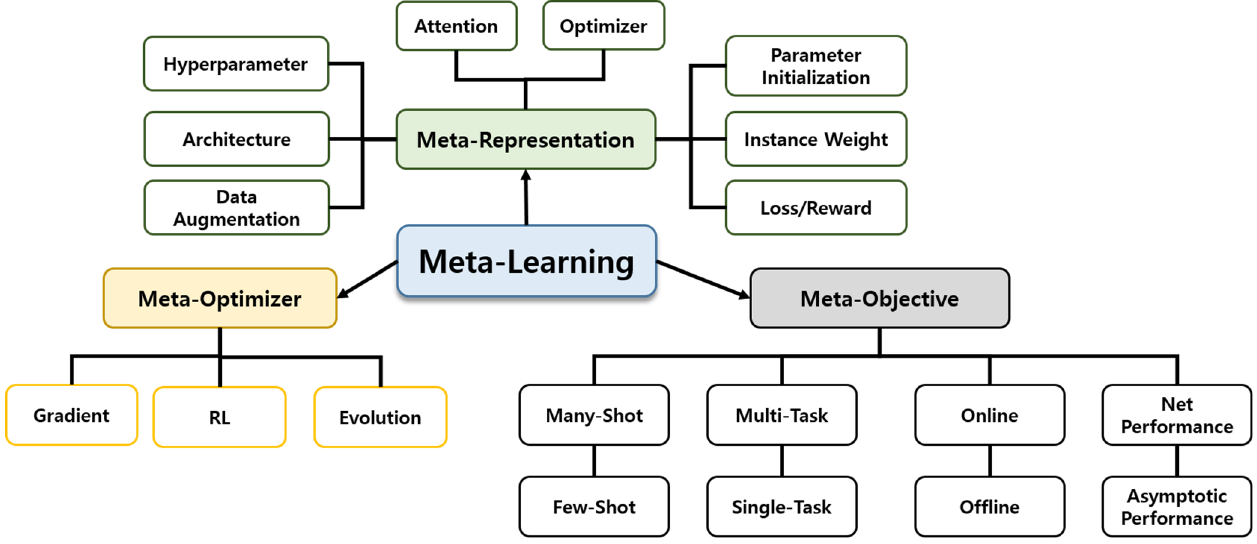
Figure 2. Meta ‐ learning technology trend diagram. Figure 2. Meta-learning technology trend